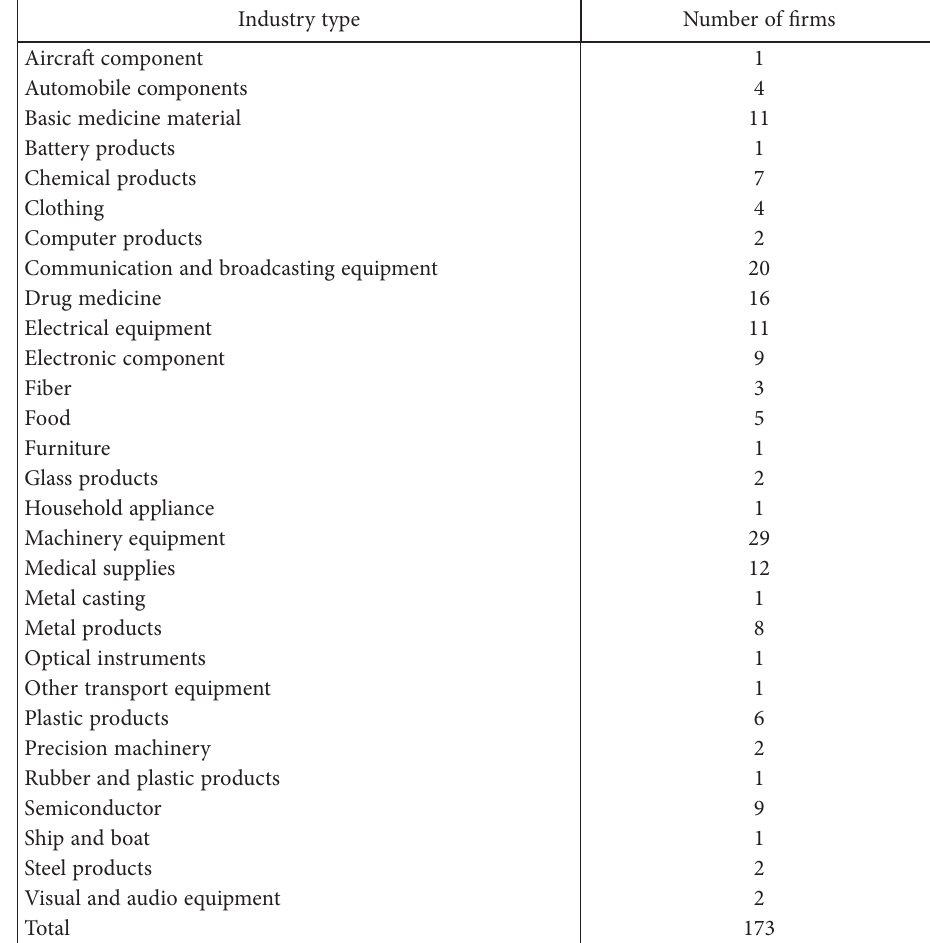
Table 1. Industry distribution of small and medium sized enterprises Industry type Number of